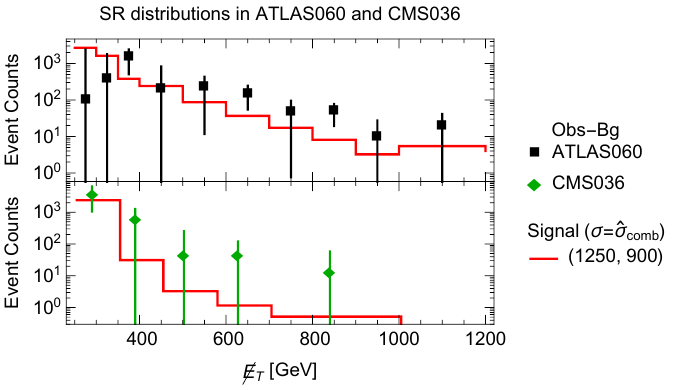
Figure 4 . Di(cid:11)erence between observed and background counts with relative error bars for AT- LAS060 (black) and the CMS036 N j = 1 bins (green), to be compared with the =E the signal for ( m (cid:30) ; m ) = (1250 ; 900), respectively in solid and dashed red, given the production cross section set by the joint (cid:12)t to ATLAS060 and CMS036.